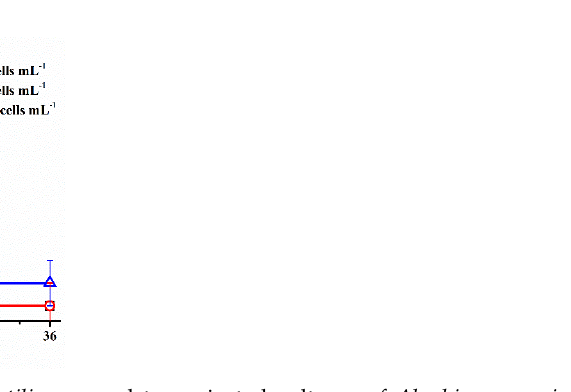
Figure 3. Strains of Akashiwo sanguinea JX13, JX14 and AS2 co-cultured with Rhodomonas salina CCMP1319. ( A , B ): JX13 co-cultured with R. salina ; ( C , D ): JX14 co-cultured with R. salina ; ( E , F ): AS2 co-cultured with R. salina . Initial cell density of R. salina was 1000 cells mL − 1 . Results are expressed in triplicate ± standard deviation (SD). Different lower-case letters (a, b, c) indicate significant dif- ferences ( p < 0.05) between treatments at the same time; * and ** indicate significant differences ( p < 0.05 and p < 0.01, respectively) between treatment and control. 3.2.2. Variations of A. sanguinea Toxicity among Different Growth Stages and between Extra- and Intra-Cellular Fractions Cell-free filtrate of A. sanguinea JX14 showed significant inhibitory effects on R. salina CCMP1319 ( p < 0.05), and inhibition rates of filtrate in stationary (11%) and decline (13%) phases were significantly higher than those in the exponential phase (3%) at 24 h ( p < 0.05, Figure 4A). The inhibition rate of JX14 cell pellets in exponential phase (33%) was significantly higher than that in stationary phase (26%) at 48 h ( p < 0.05), while decline-phase cell pellets showed a growth-promoting effect on R. salina . The growth-inhibition effects of JX14 cell pellet on R. salina in exponential and sta- tionary phases were about 3 times those of associated filtrates.